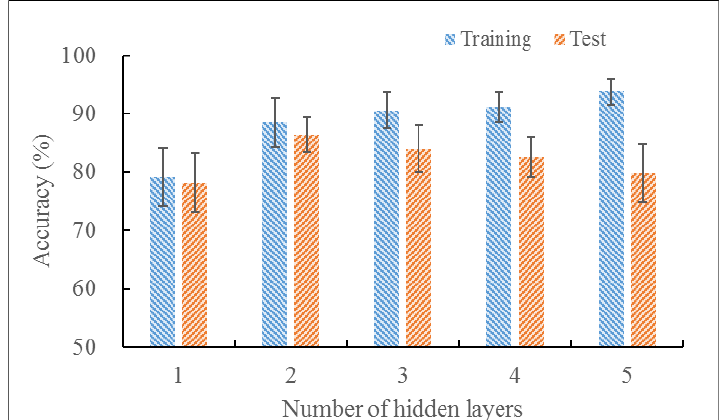
Figure 9. The relationship between the number of hidden layers and recognition rate.